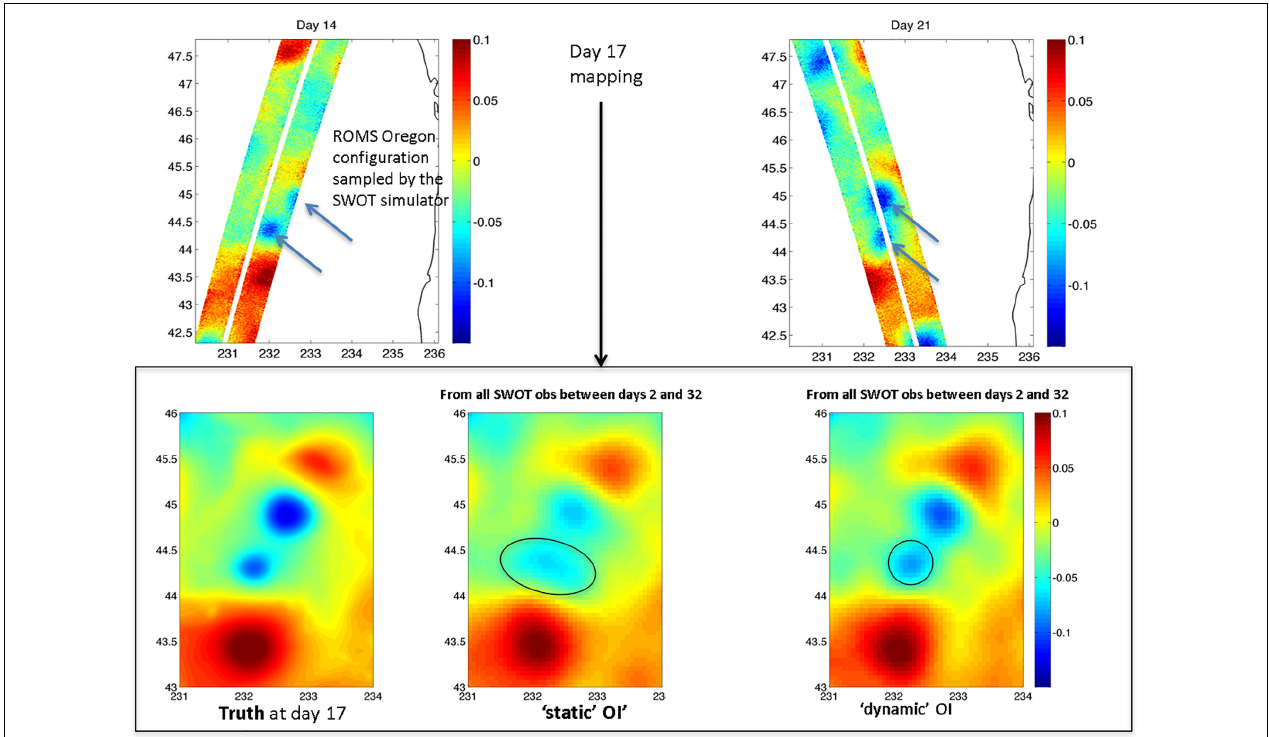
FIGURE 9 | Upper panels: SWOT Level 3 data shown for day 14 and day 21 in a simulation off the Oregon coast. Lower panels: from left to right: reference field, analyzed field with static optimal interpolation and analyzed field with dynamic interpolation on day 17, processing all data available between days 7 and 27 ( Credits: NASA-JPL